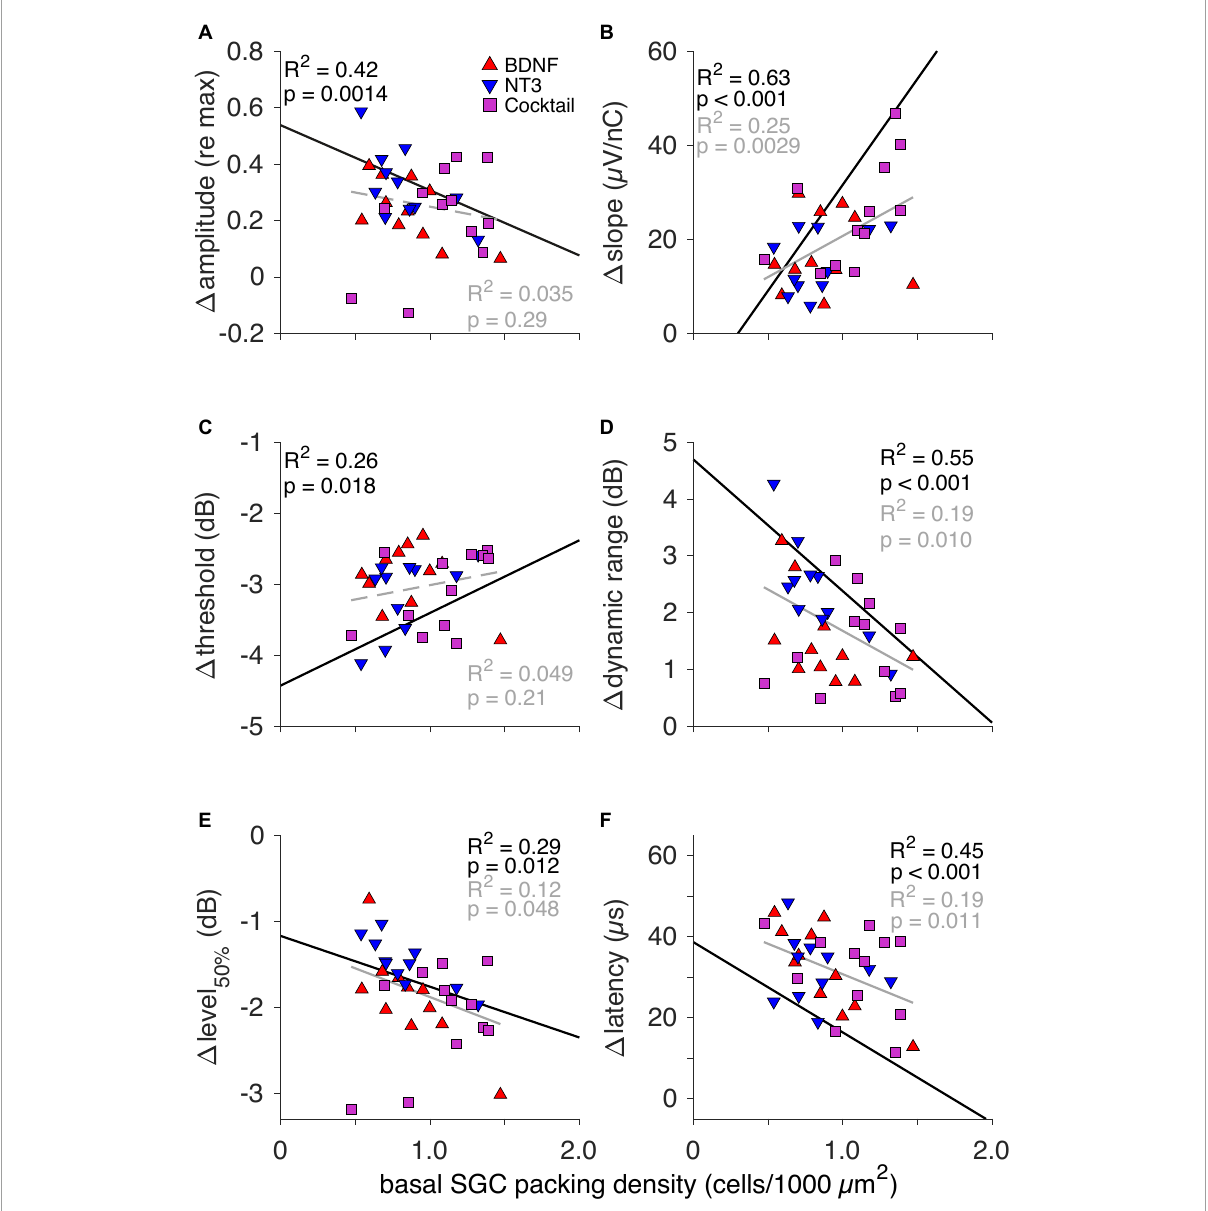
FIGURE6 The IPG effect for all six eCAP characteristics as a function of basal SGC packing density for individual neurotrophin-treated animals only. Black text and regression lines represent the correlation between the (cid:49) IPG measure and SGC packing density for both NH and the sham-treated PBS (i.e., non-neurotrophin-treated) groups. The gray text and regression lines represent this correlation for the neurotrophin-treated animals only. Solid lines indicate an R 2 value with p < 0.05; dashed lines indicate p > 0.05. (A) (cid:49) amplitude, (B) (cid:49) slope, (C) (cid:49) threshold, (D) (cid:49) dynamic range, (E) (cid:49) level 50% , and (F) (cid:49) latency.